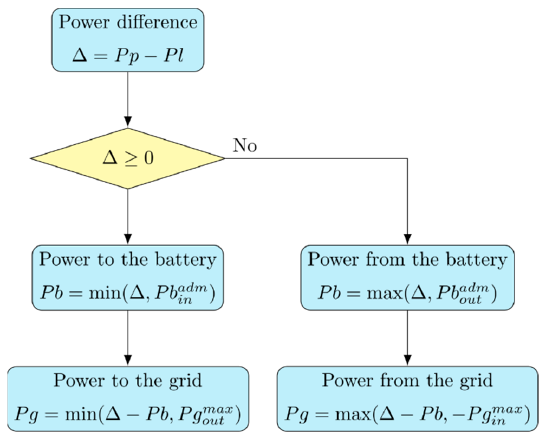
Figure 8. Flowchart of RBC1.